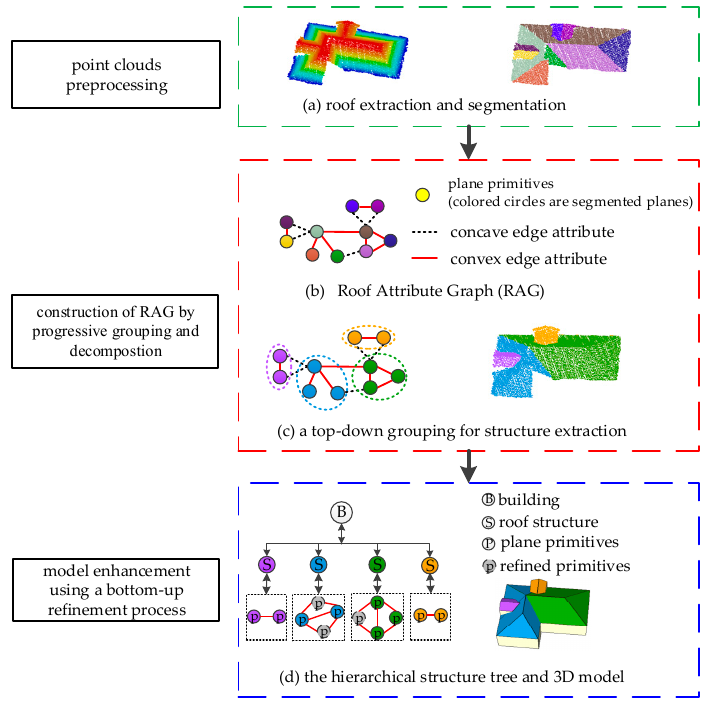
Figure 1. The pipeline of the proposed method.